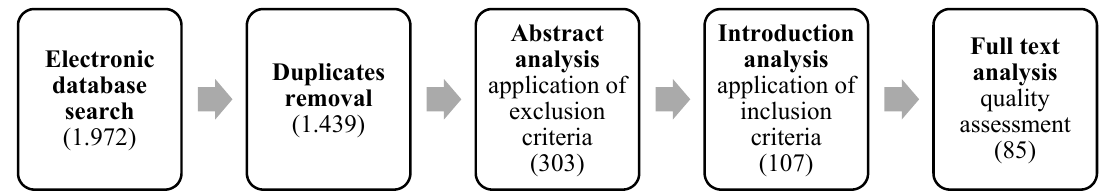
Figure 1. Article selection stages.